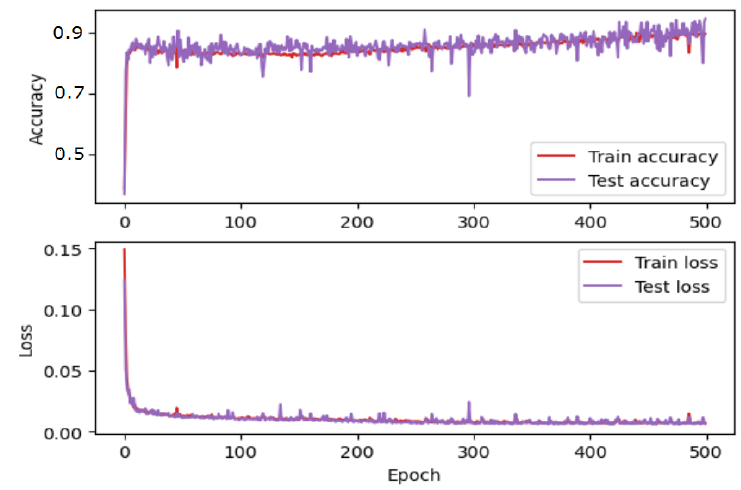
Figure 15. Accuracy corresponding to the second architecture.